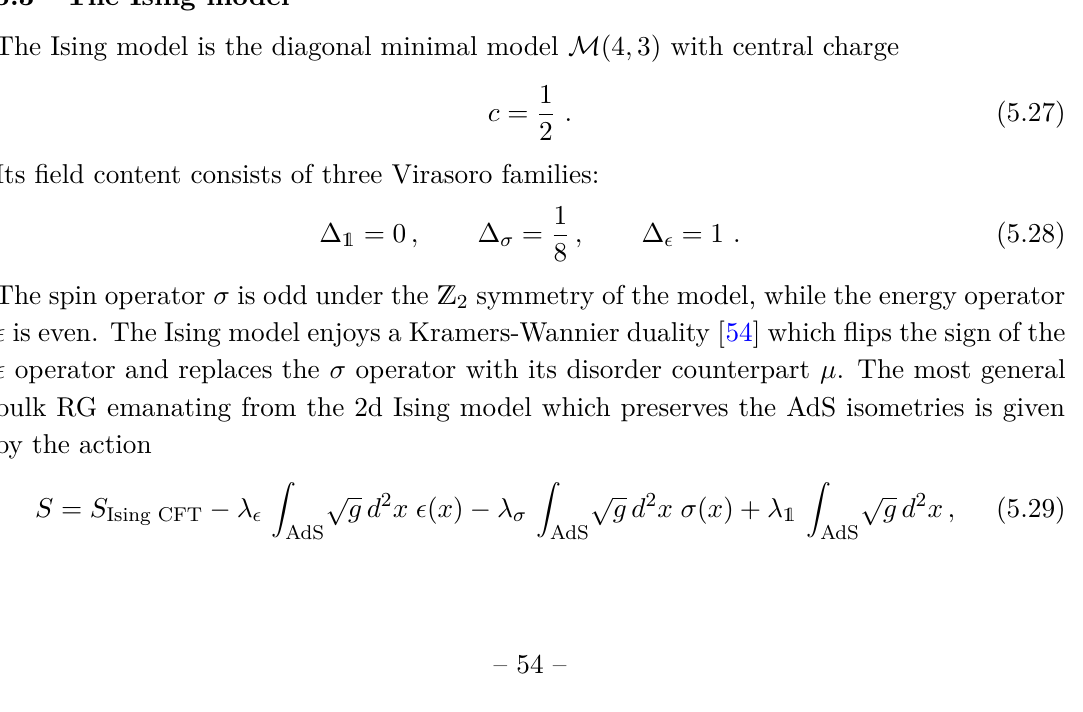
defined in the main min